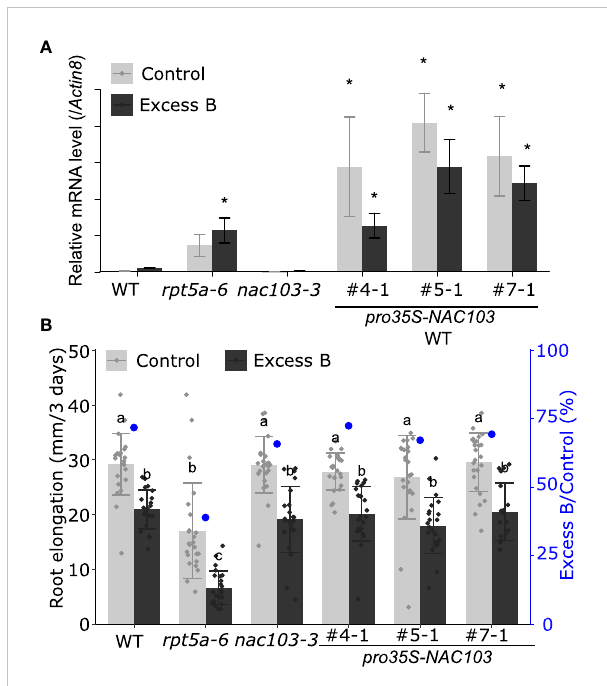
FIGURE 3 Effect of NAC103 expression on excess boron sensitivity in root growth. (A) NAC103 mRNA accumulation in rpt5a-6 mutant and NAC103 overexpression lines. Seedlings were grown for six days under control or excess boron conditions. Total RNA was extracted from whole root and NAC103 mRNA accumulation was quanti fi ed by qRT-PCR. Expression levels were normalized by Actin8 . Values represent mean ± standard deviation of three biological replicates. Asterisk indicate signi fi cant difference from the wild type in the same condition at p < 0.05 by Dunnett ’ s test. (B) Root elongation of NAC103 overexpression lines. Seedlings were precultured in normal conditions (30 µM boric acid) for six days and then transferred to excess boron (3 mM boric acid) or control conditions. Root elongation during three days after the transfer was measured. Numbering with # indicates transformant lines isolated independently. Values are mean ± standard deviation of 18-24 measurements. Groups sharing the same letters are not signi fi cantly different at p < 0.05 by Tukey-Kramer ’ s